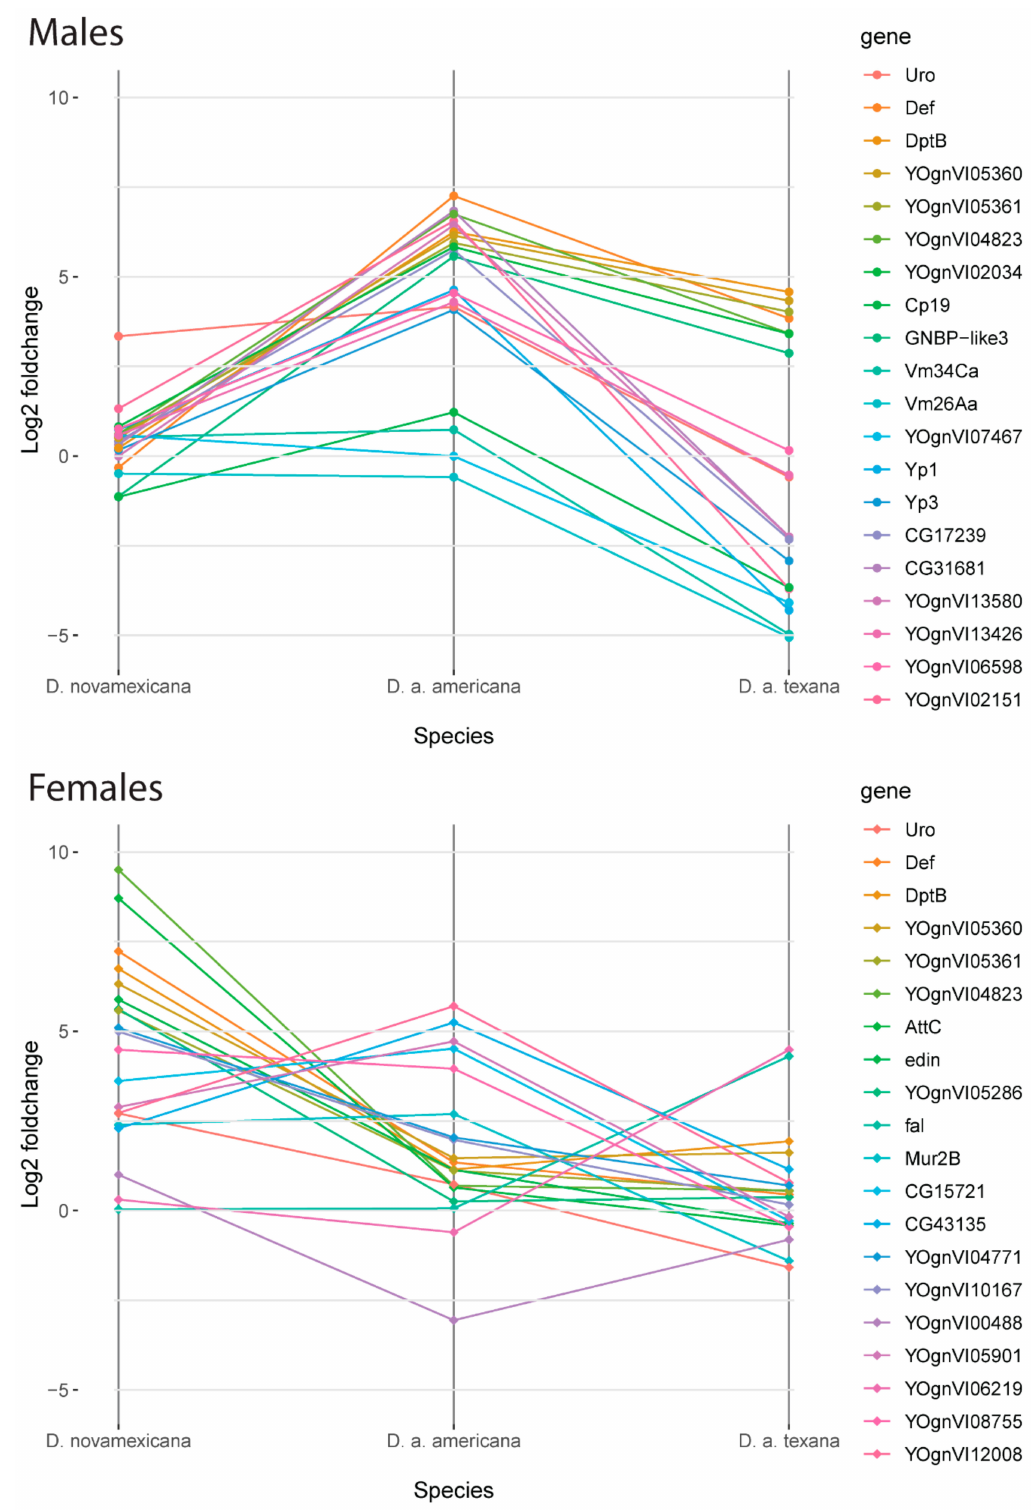
Figure 4. Top 20 genes by greatest between-species variance in fold-change for males (top) and females (bottom). Six genes: Uro, Def, DptB, YOgnVI05360, YOgnVI05361 , and YOgnVI04823 are shared between males and females, and all but Uro show opposing patterns between the sexes. Functional information about these genes is given in Tables 2 and